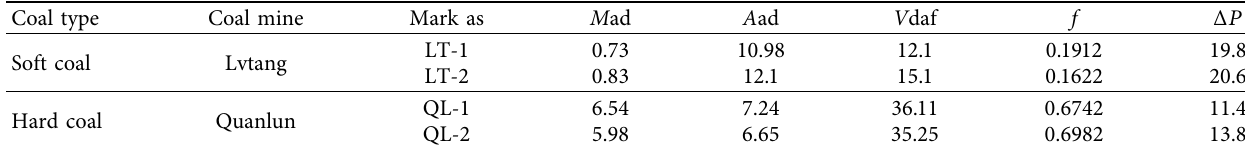
Figure 3: Humidification process for the coal samples. Table 1: Experiment and proximate analysis data of coal samples.